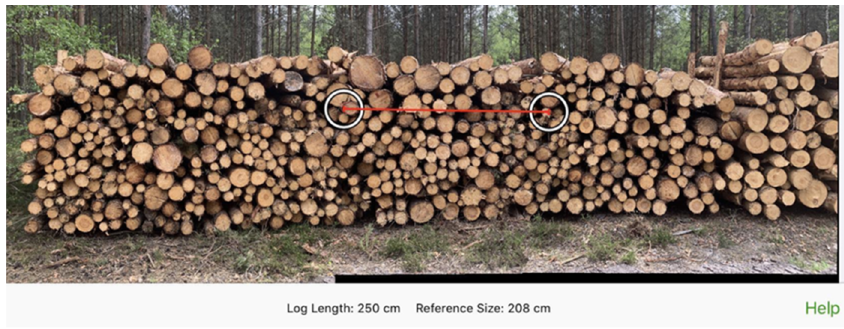
Figure 2. Automatic identification and determination of diameters of the stacked wood pieces by the Timbeter application. (Fot. T. Moskalik).